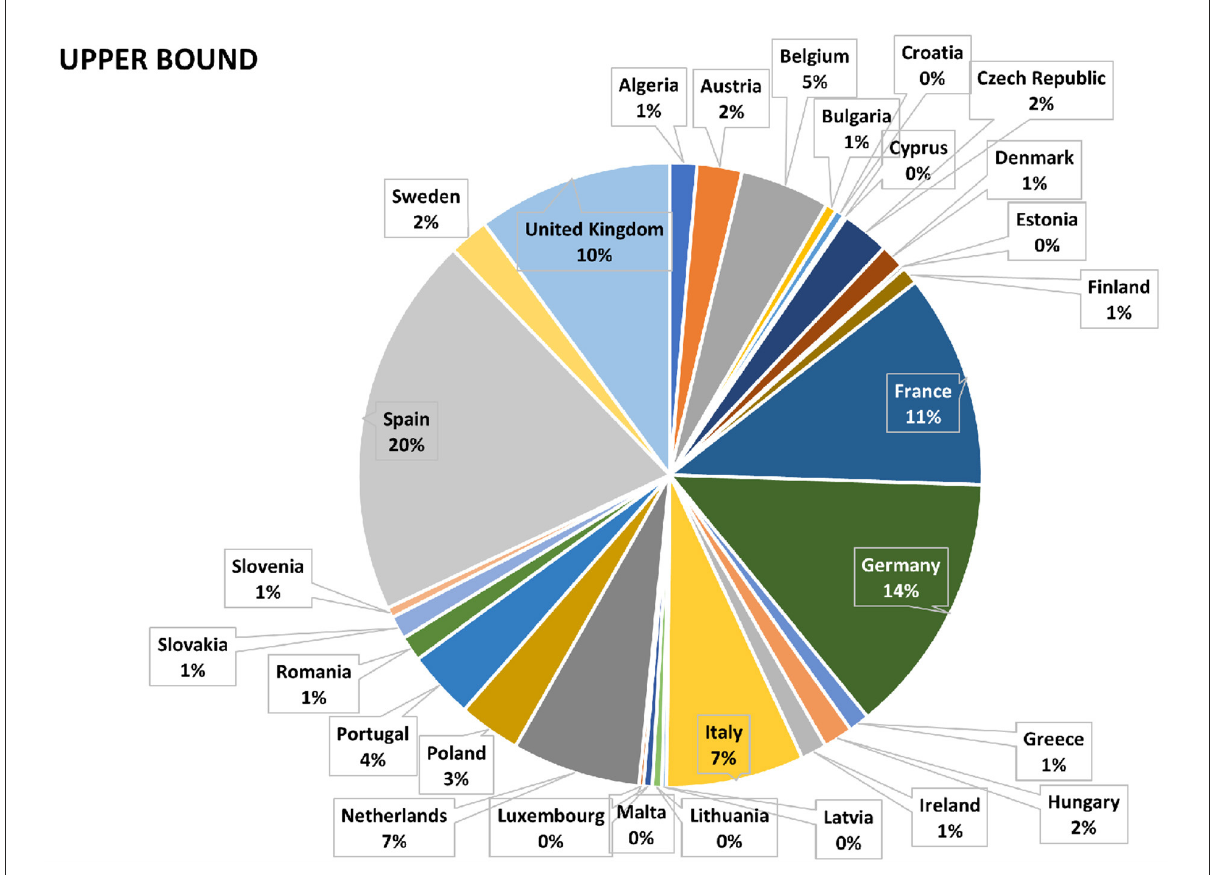
FIGURE9 Percentages of upper bound losses for 3 days of delay caused by a cyber-physical